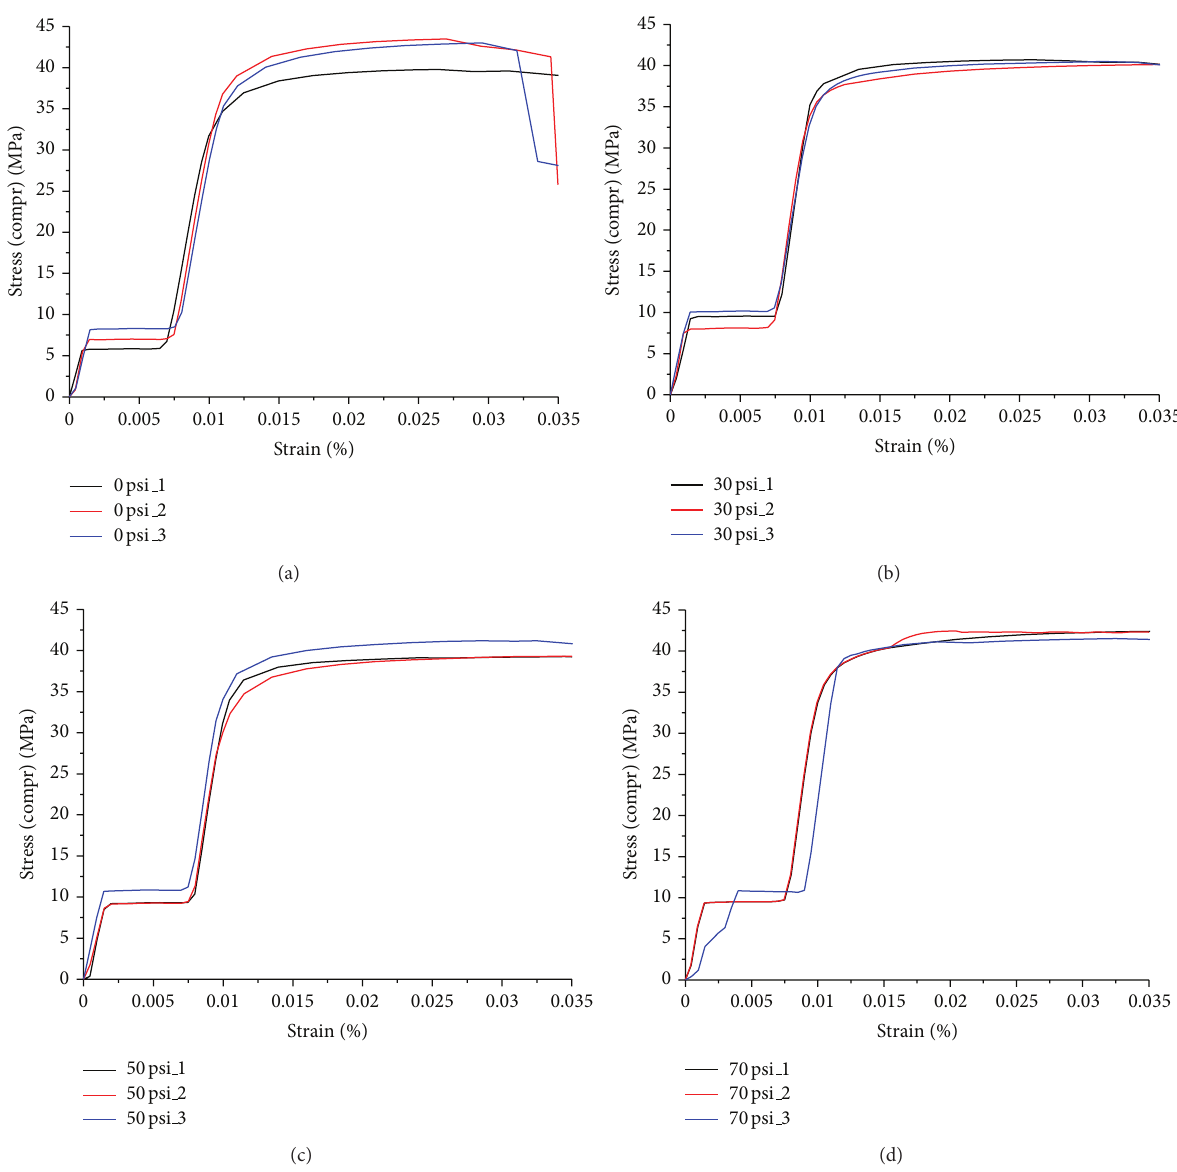
Figure 16: Compression testing stress-strain curves for (a) 0 psi, (b) 30 psi, (c) 50psi, and (d) 70